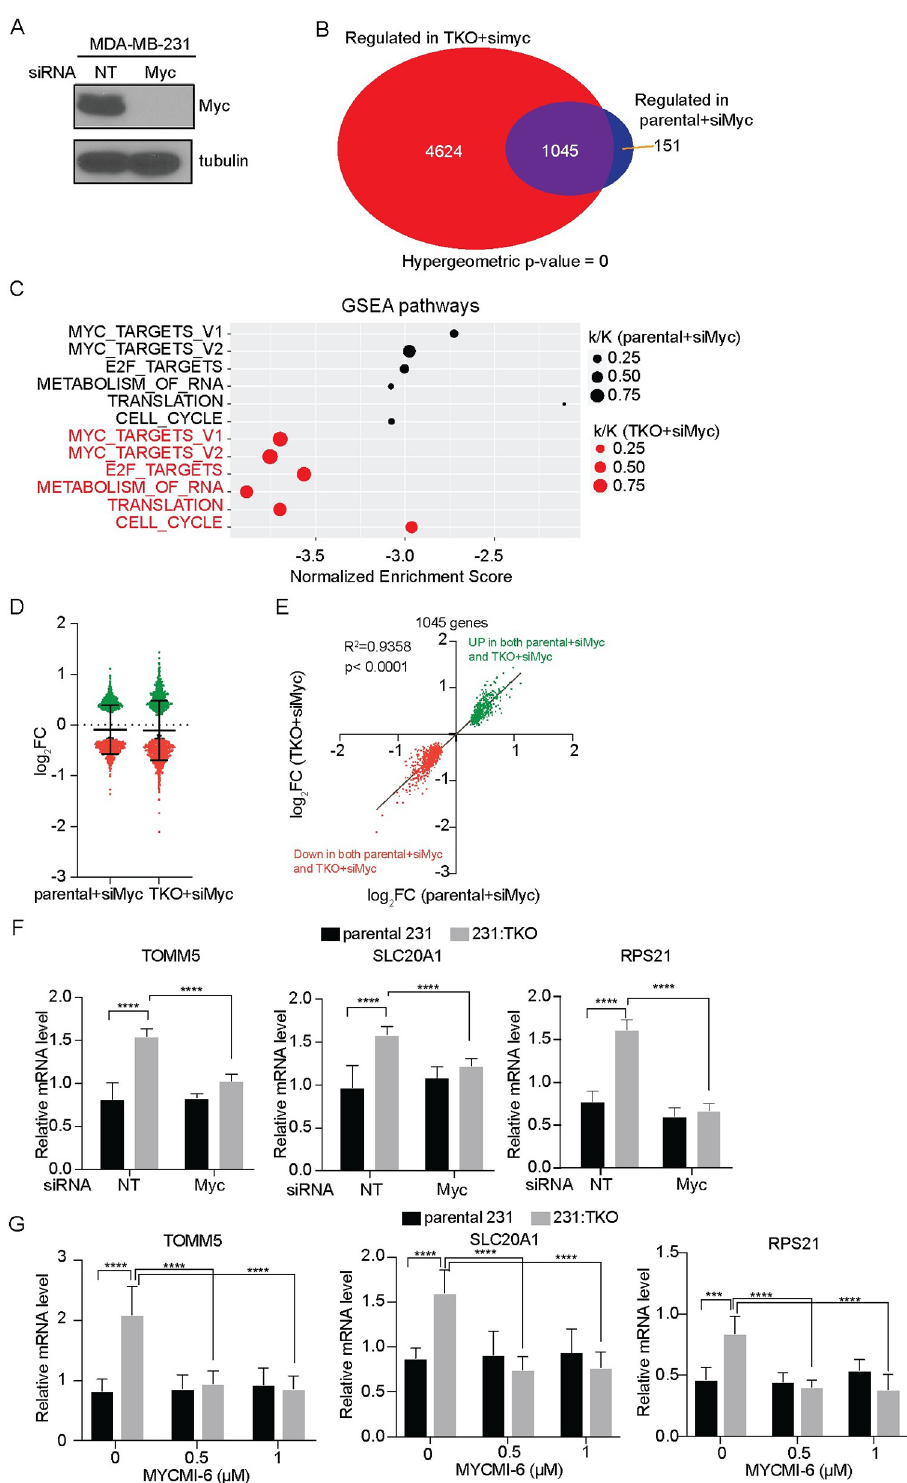
Fig 6. TXNIP loss expands the Myc transcriptome. ( A ) Western blotting was used to determine levels of Myc and tubulin in parental 231 cells following a 48-hour treatment with siNT or siMyc. ( B ) Myc-regulated genes in parental 231 and in 231:TKO cells were compared. ( C ) Preranked GSEA was performed using ranked genes lists from Myc- dependent targets in parental 231 and 231:TKO cells and the Hallmark and Reactome data sets from the MSigDB.